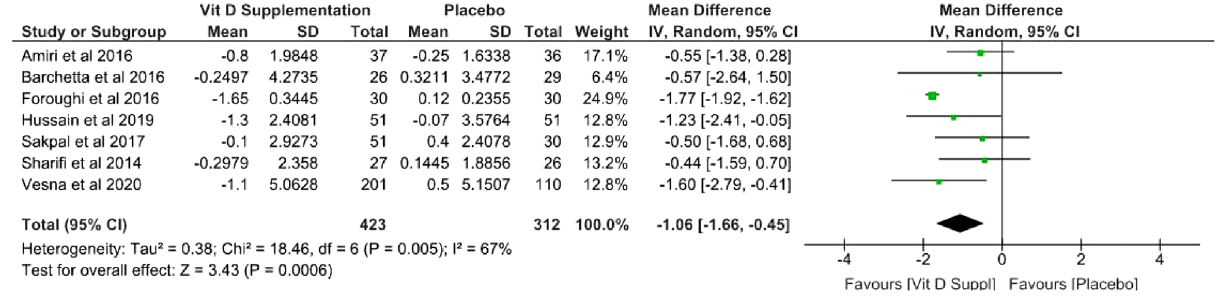
Figure 3. Forest plot of insulin